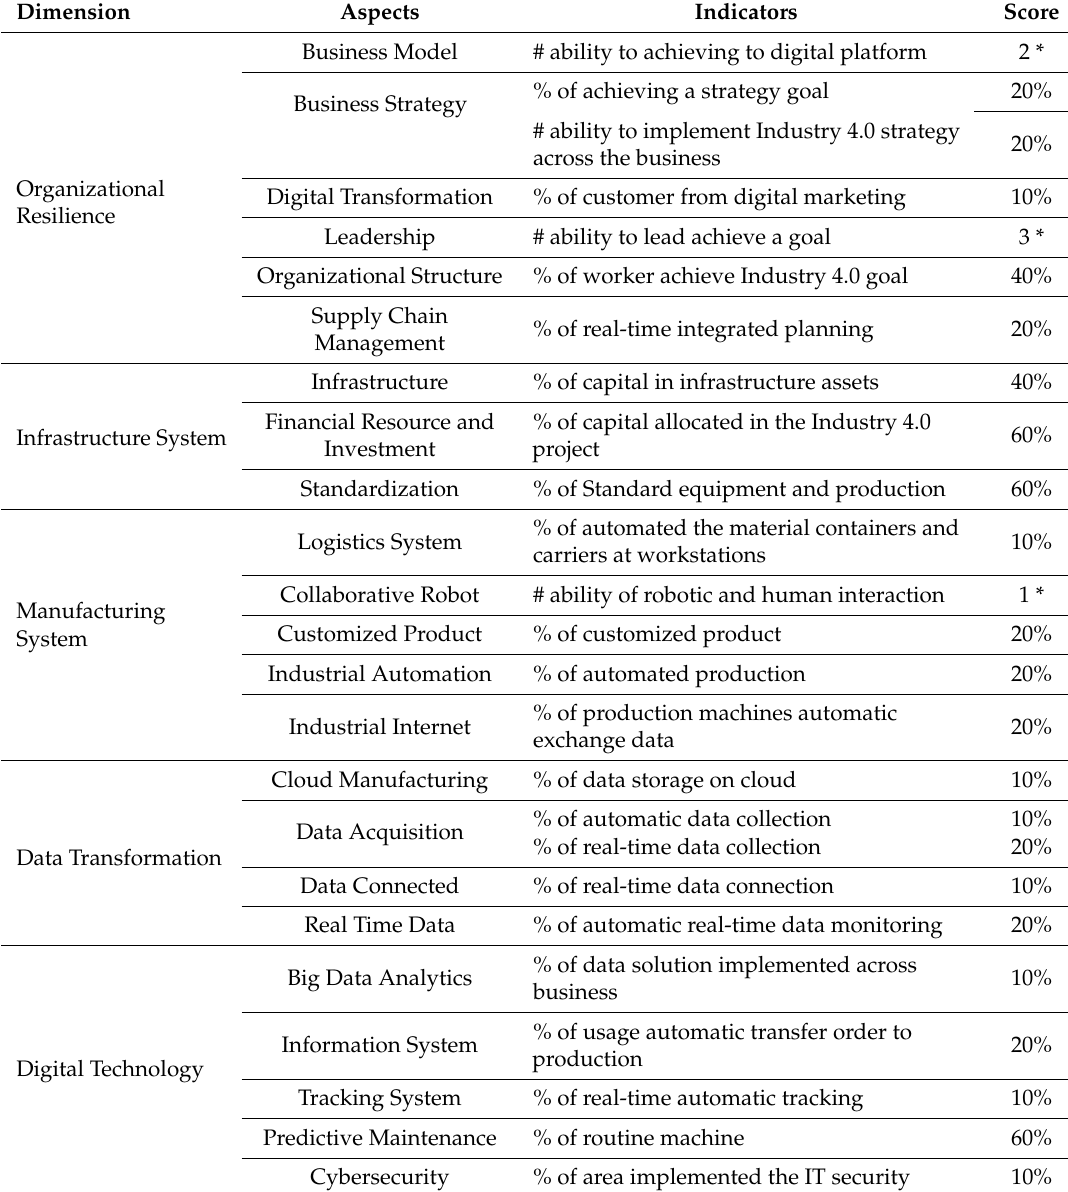
Table 8. Example of SMEs 4.0 readiness indications